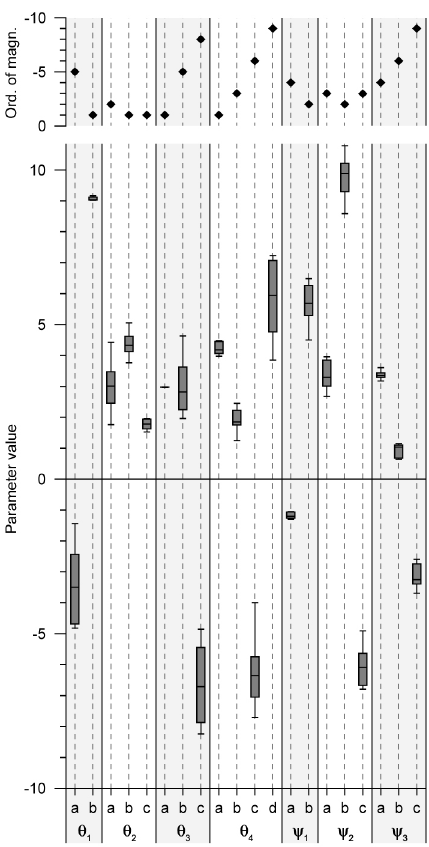
Fig. 7. Sensitivity of modelled albedo values towards variations of the individual parameter functions θ 1 − 4 (z) and ψ 1 − 3 (z) of the FAM (given in the lower right corner of each graph) shown as scat- ter plots between observed and modelled albedo values. The size of the circles indicate the magnitude of sensitivity, i.e. of albedo devi- ation ( 1α ). The colour of the circles indicate the associated month. Given albedo deviations reflect the model sensitivity within the ± one standard deviation uncertainty ranges of the parameter func- tions (Fig.